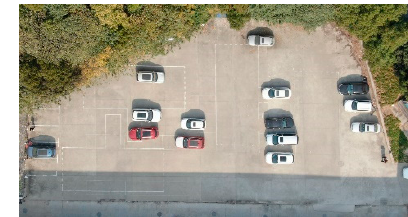
Figure 4. Target parking lot. Appl. Sci. 2019 , 9 , 5016